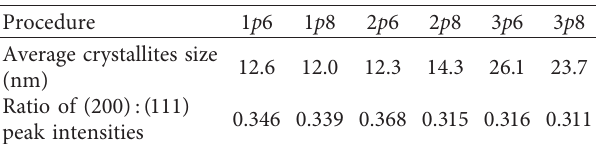
Table 1: Average crystallite sizes of Cu procedures.